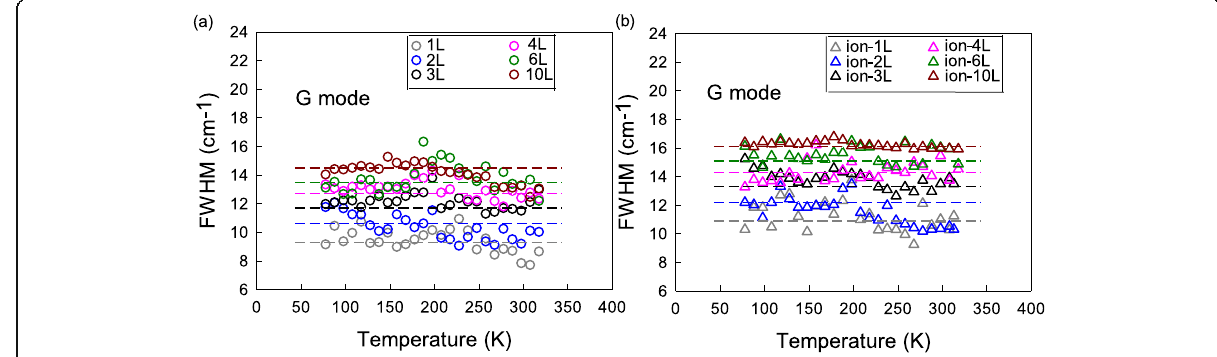
Fig. 4 The T-dependent FWHM(G) of 1LG-4LG, 6LG, and 10LG for a defect-free and b defective sets in the temperature range of 78 – 318 K